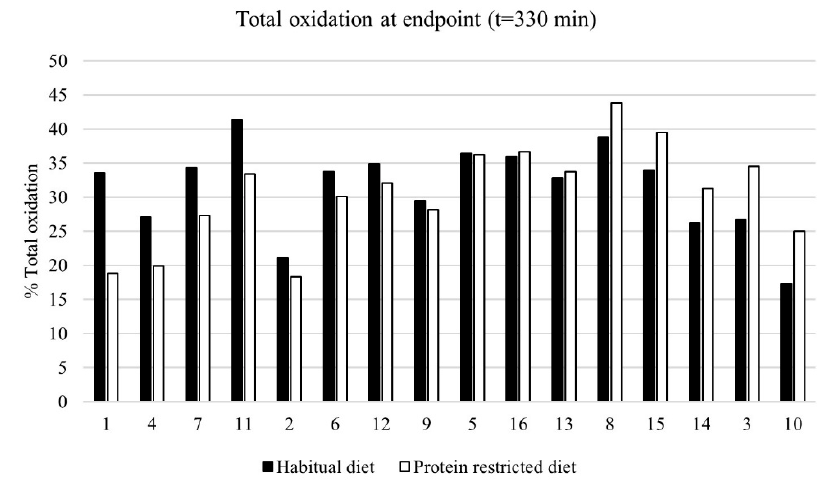
Figure 3. Total protein oxidation (% of given 30 g dose) measured with the breath test after a habitual diet (black bars) versus the protein restricted diet (0.25 g/kg body weight/day)(white bars) ( n = 16). Subjects are ordered from left to right, based on the strongest relative reduction in protein oxidation from their habitual diet to the protein restricted diet, towards the strongest relative increase.